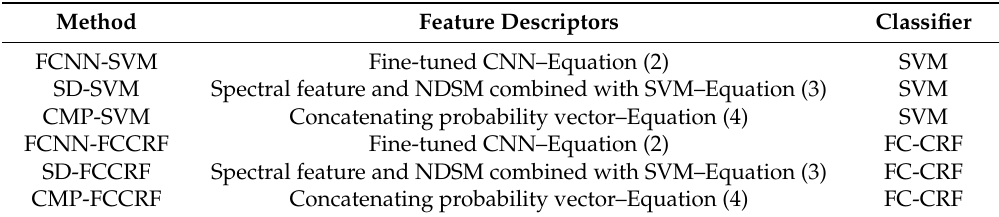
Table 2. Information of different classification